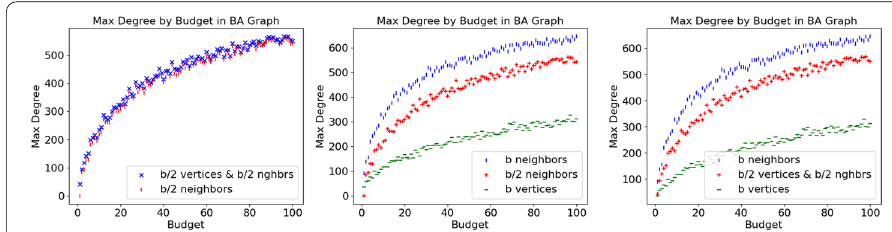
Fig. 4 Comparison of RN and RVN for maximizing the max‑degree in random